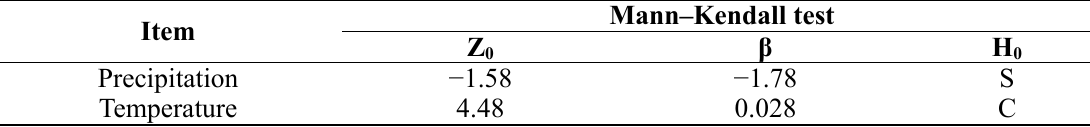
Table 1. Monotonic trend tests for the precipitation and temperature time